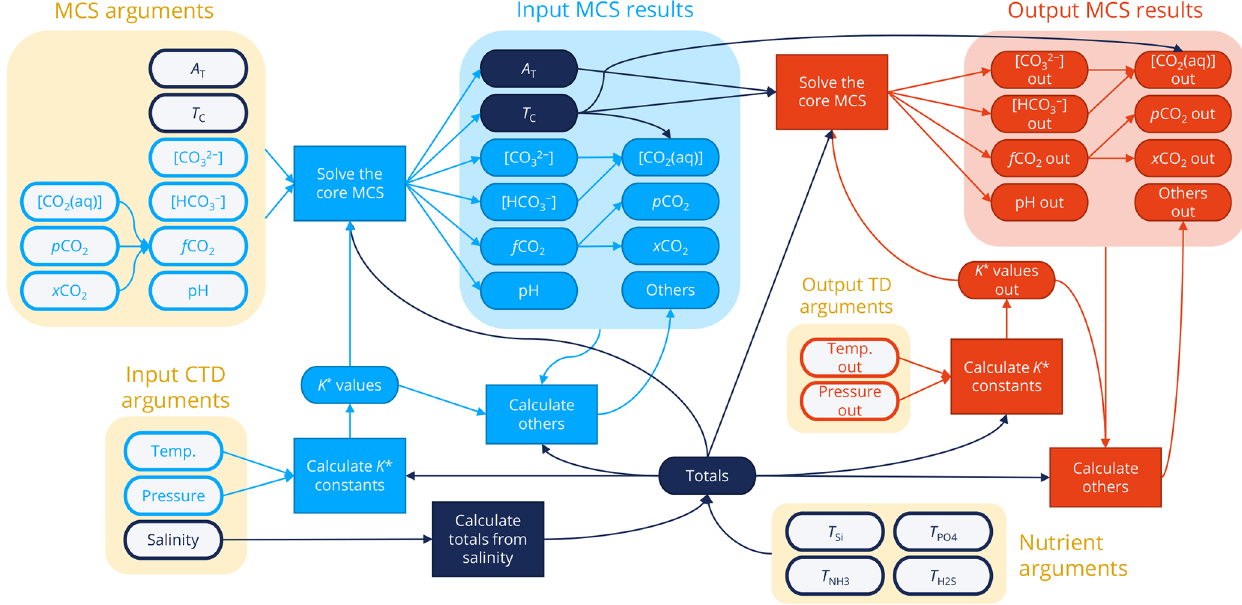
Figure 1. Overview of the process by which PyCO2SYS and other CO2SYS implementations solve the marine carbonate system (MCS) and calculate other results. Arguments provided by the user are shown as open symbols on a yellow background, while calculations and results use filled symbols. Components under input conditions are shown in light blue, those under output conditions are in red towards the right, and components that are independent of input/output conditions are in dark blue. Any pair of the parameters in the “MCS arguments” box at the top left can be provided, noting that only one of [ CO 2 ( aq ) ] , p CO , f CO , or x CO may be included in a pair. Coupled with user-provided 2 2 2 nutrients, total salts calculated from salinity (Totals), and stoichiometric dissociation constants calculated from salinity and input temperature and pressure ( K ∗ values), all core MCS parameters are determined (Input MCS results) from the known pair (Appendix C). Other results (e.g. carbonate mineral saturation states, buffer factors) are then calculated from the results under input conditions (Others). If the user provides output-condition temperature and/or pressure values, then the dissociation constants are recalculated under these new conditions, the core MCS is solved again (Output MCS results) from these updated constants ( K ∗ values out), the original “totals”, and the now-known A T and T C , which are independent of temperature and pressure. Finally, other results are calculated again from the output-condition results (Others